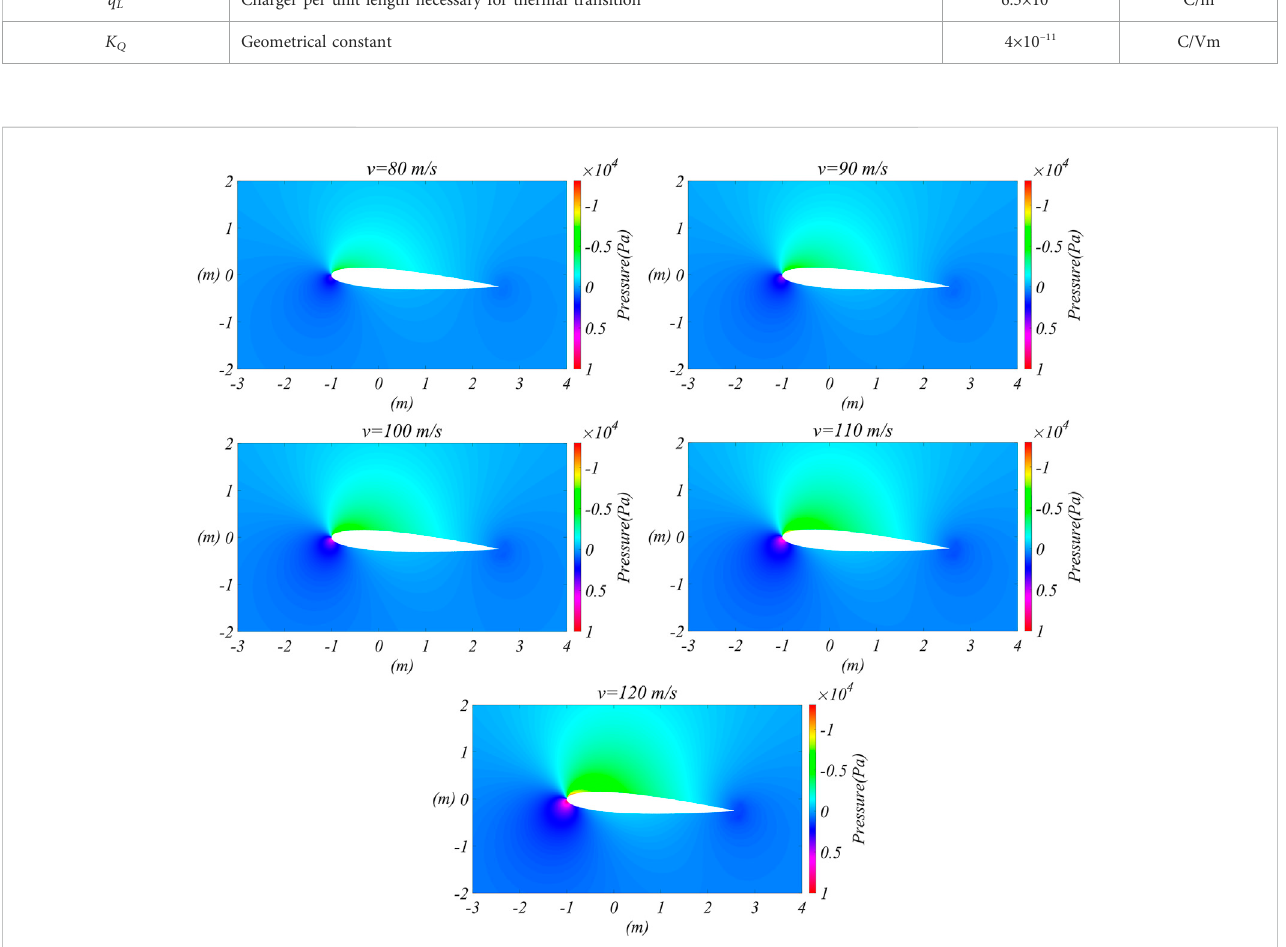
FIGURE 3 The air pressure distribution at different velocities around wind turbine